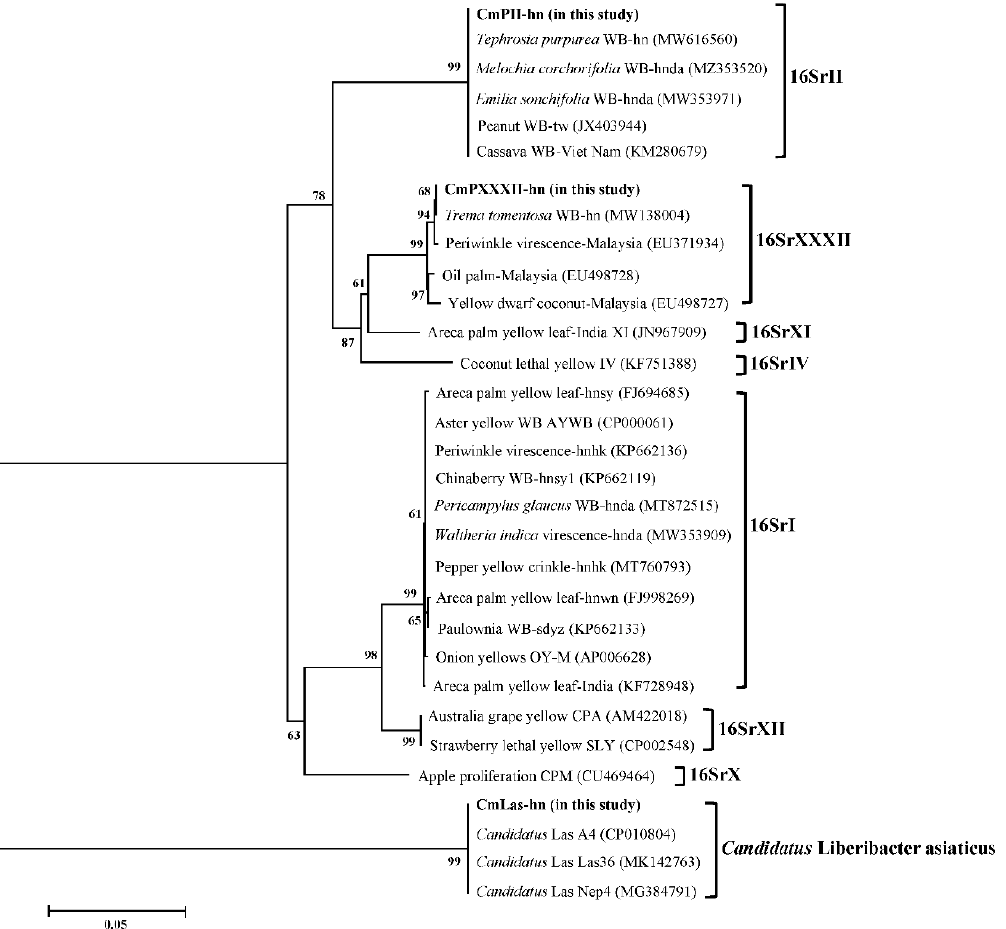
Figure 4. Phylogenetic tree constructed based on the 16S rRNA gene sequences of the phytoplasma and the Candidatus Liberibacter asiaticus strains employing the neighbor-joining method. Scale bar length represents inferred character-state changes. Branch lengths are proportional to the number of inferred character-state transformations. The percentage of replicate trees in which the associated taxa clustered together in the bootstrap test (1000 replicates) is shown next to the